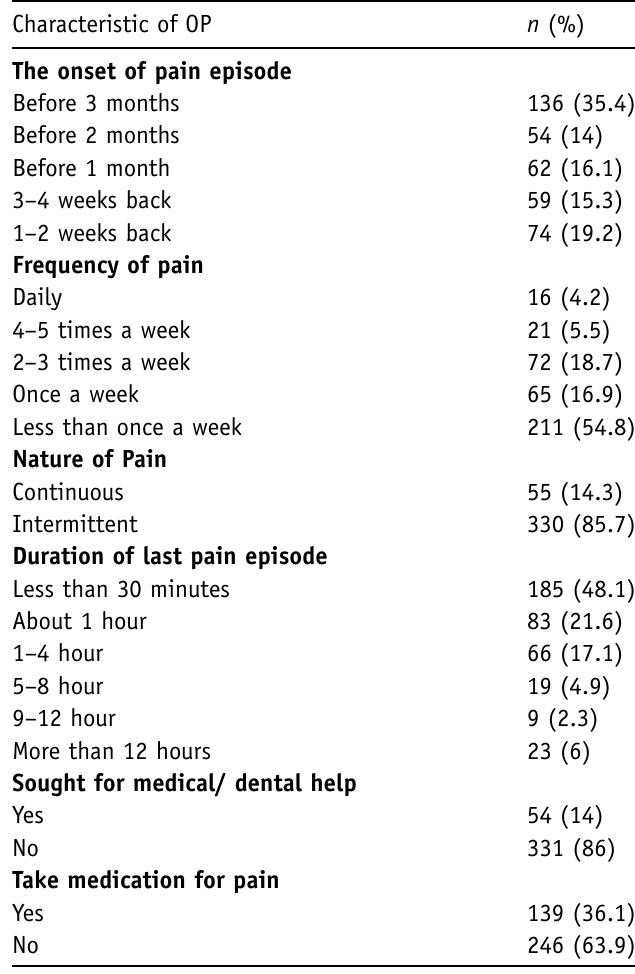
Table II. Characteristic of OP.